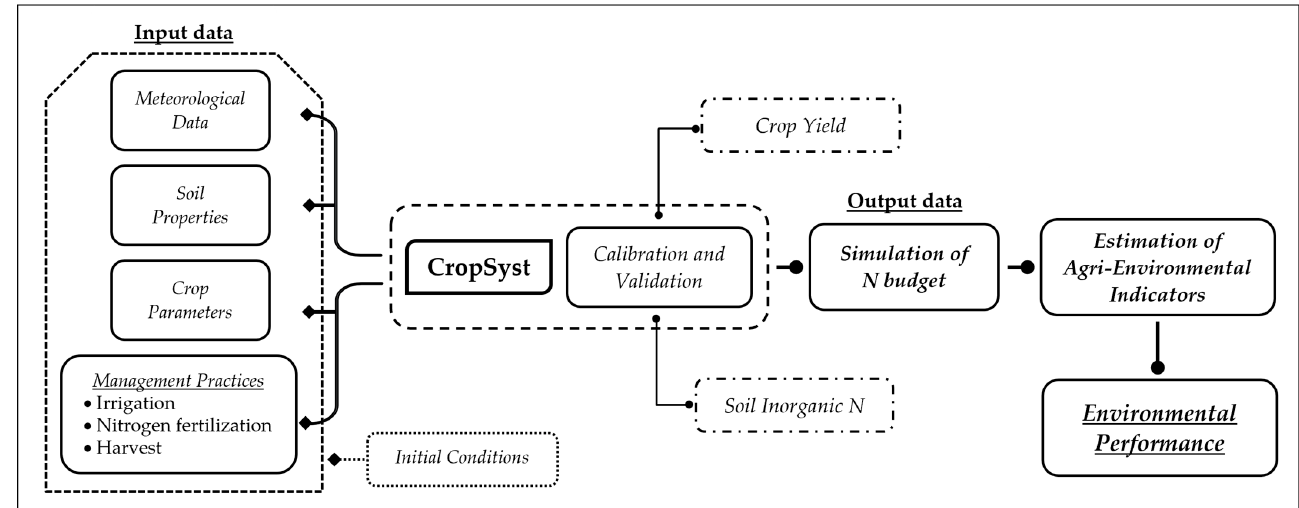
Figure 2. Flowchart of the methodology used to estimate the environmental performance of the different irrigation and N fertilization management practices in kiwi production in the present study, using CropSyst model and agri-environmental indicators.